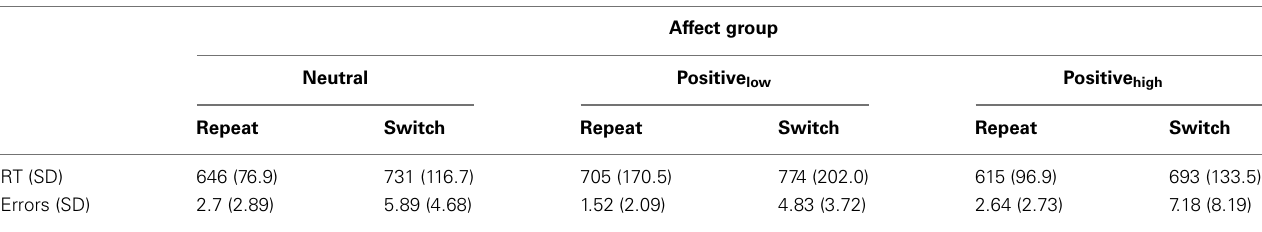
Table 3 | Mean RTs (in ms) and error rates (in %) in the in the first experimental block of experiment 3 (task switching without task cues) as a function ofAffect group andTrial type.